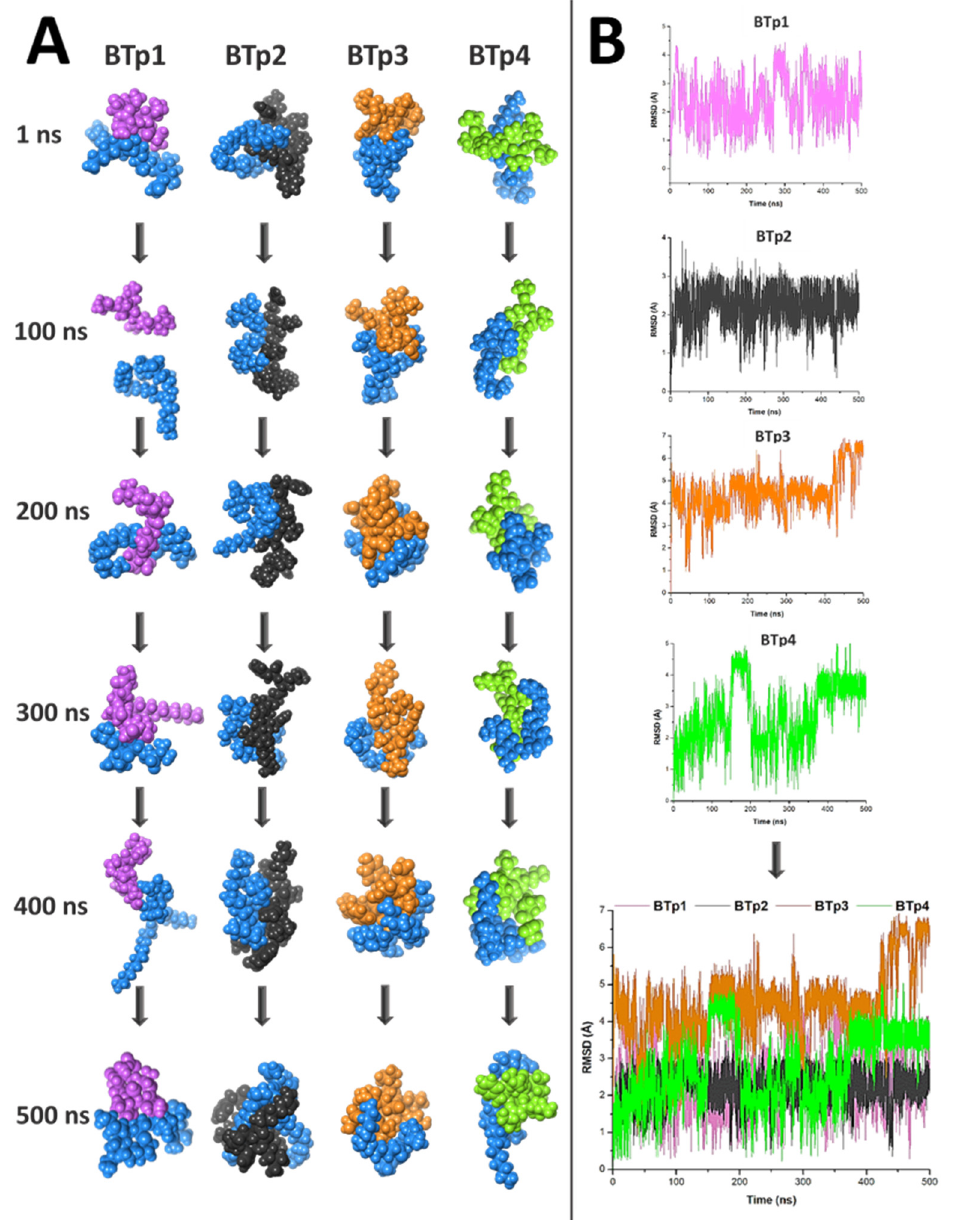
Figure 3. Trajectory analyses of four novel peptides bound to lipoteichoic acid. ( A ) Snapshots during 500 ns simulations of each peptide bound to lipoteichoic acid at 100 ns intervals. ( B ) Graphs depicting RMSD calculations of each of the four simulations and superimposed in the last graph.